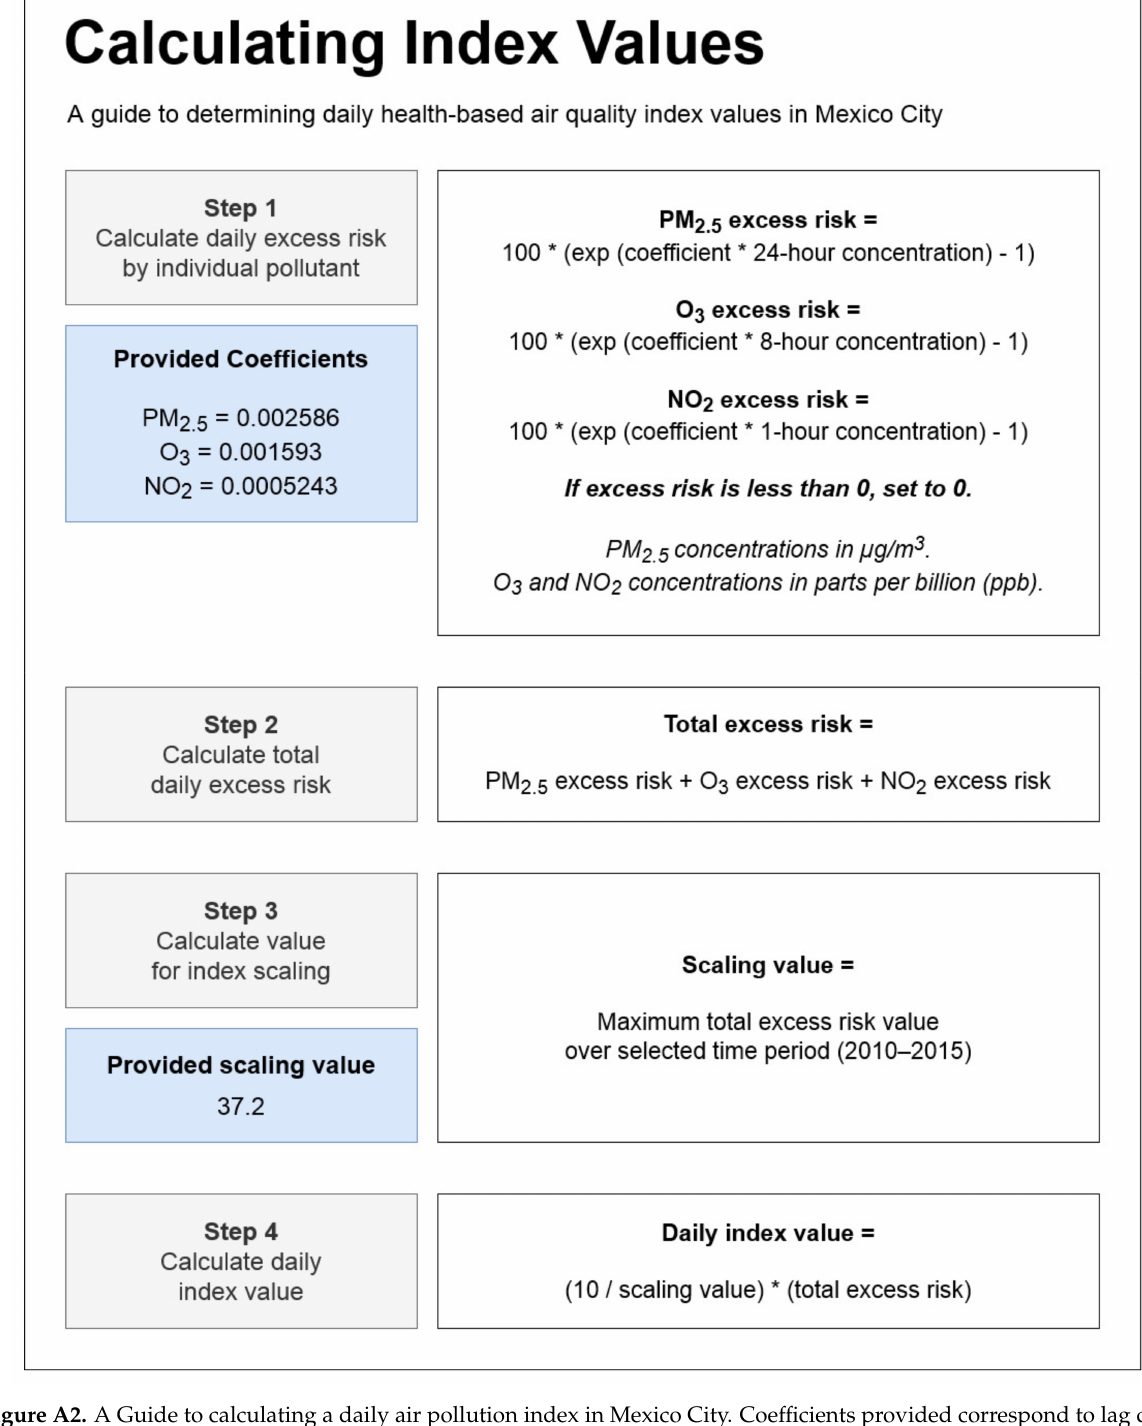
Figure A2. A Guide to calculating a daily air pollution index in Mexico City. Coefficients provided correspond to lag days 0–3 associations for the individual pollutants and respiratory ED visits for all ages of individuals. The provided scaling value corresponds to the maximum daily index value observed from 2010 to 2015. This value can be modified as desired in order to re-scale index values. Similarly, step 4 shows the creation of daily index values that range from 0 to 10. Alternative ranges of values can be used if a maximum value of 10 is not desired. It is possible that maximum excess risk will be greater than the scaling value provided, resulting in an index value greater than the maximum value selected. The precise values of these coefficients are less important than the ratio of the coeffi- cient values, which indicates the increased importance of PM 2.5 and O 3 when